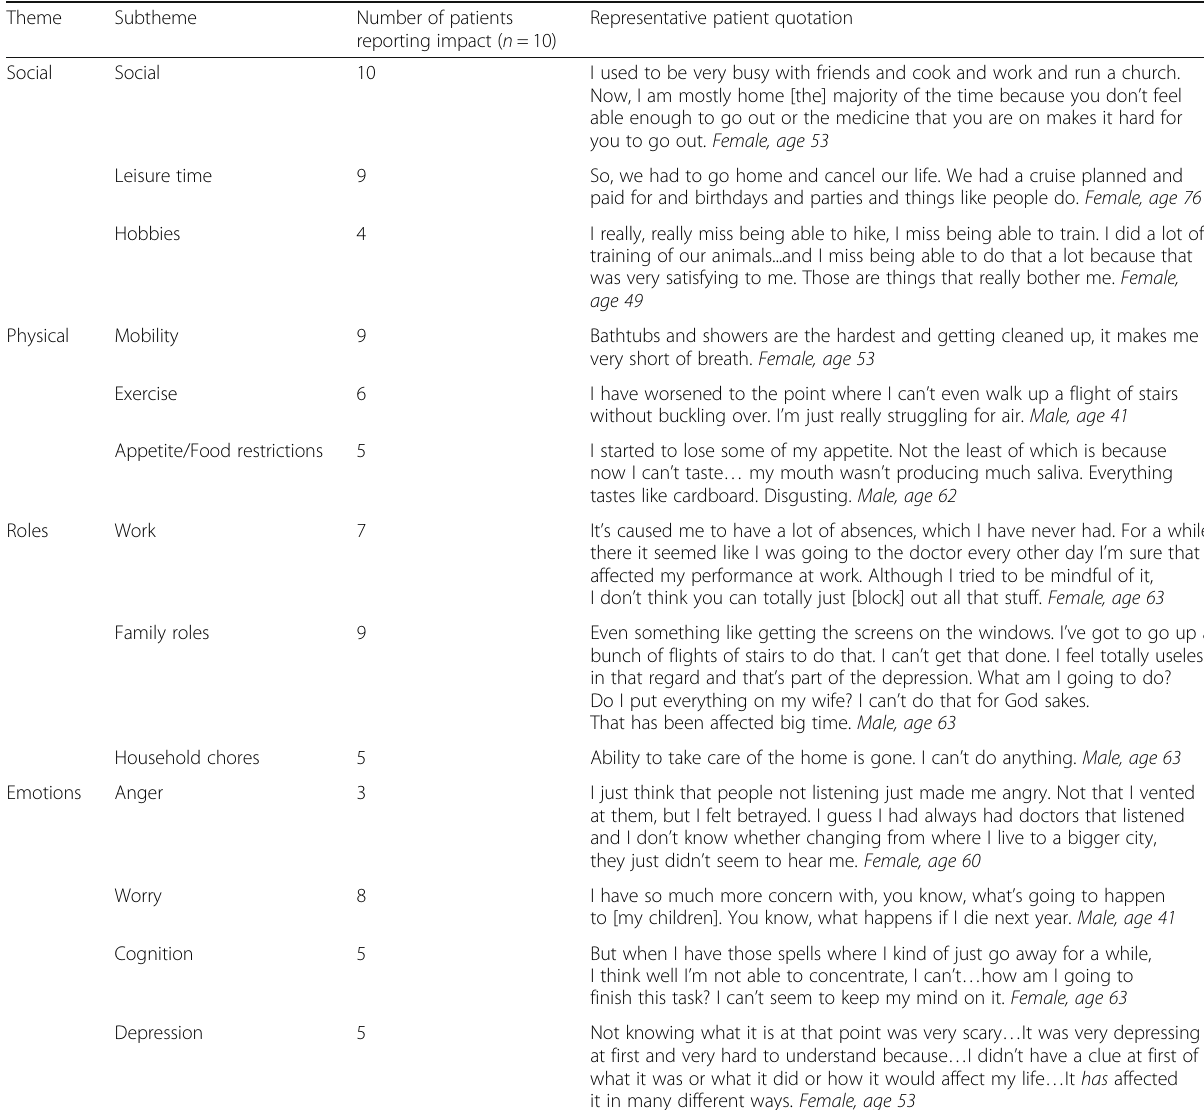
Table 3 Patient quotes on impacts of AL amyloidosis on HRQoL